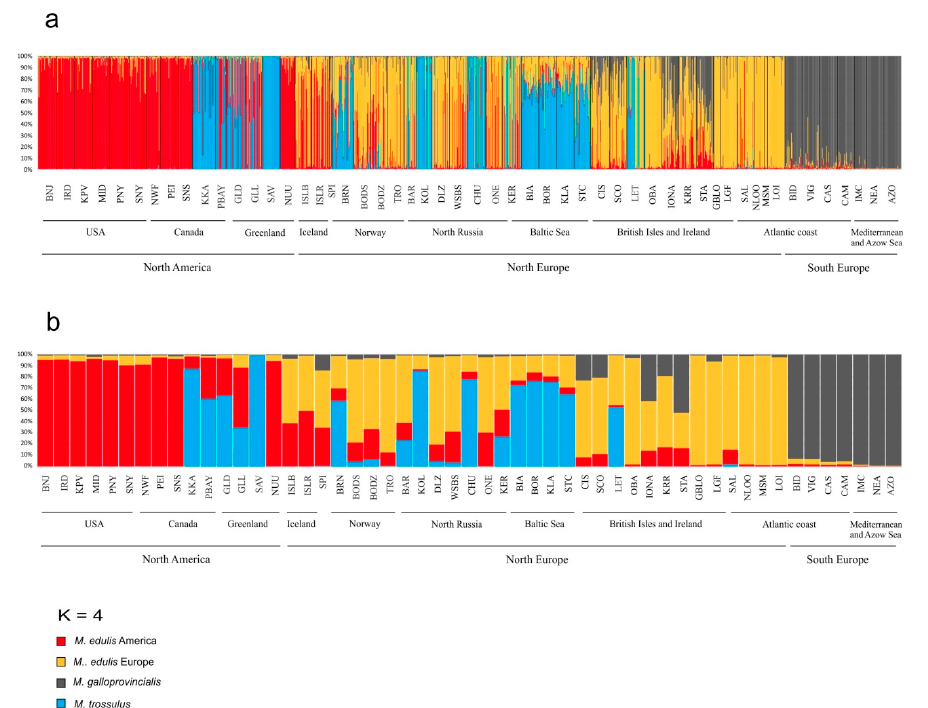
Figure 4. Plot from STRUCTURE analysis at K = 4 showing group affinities of 53 study samples. Each individual ( a ) or population ( b ) is represented by a single vertical line representing mean q value for individual and within the sample. Names of the sample sites are shown below bar plots, black vertical lines separate the sample sites.